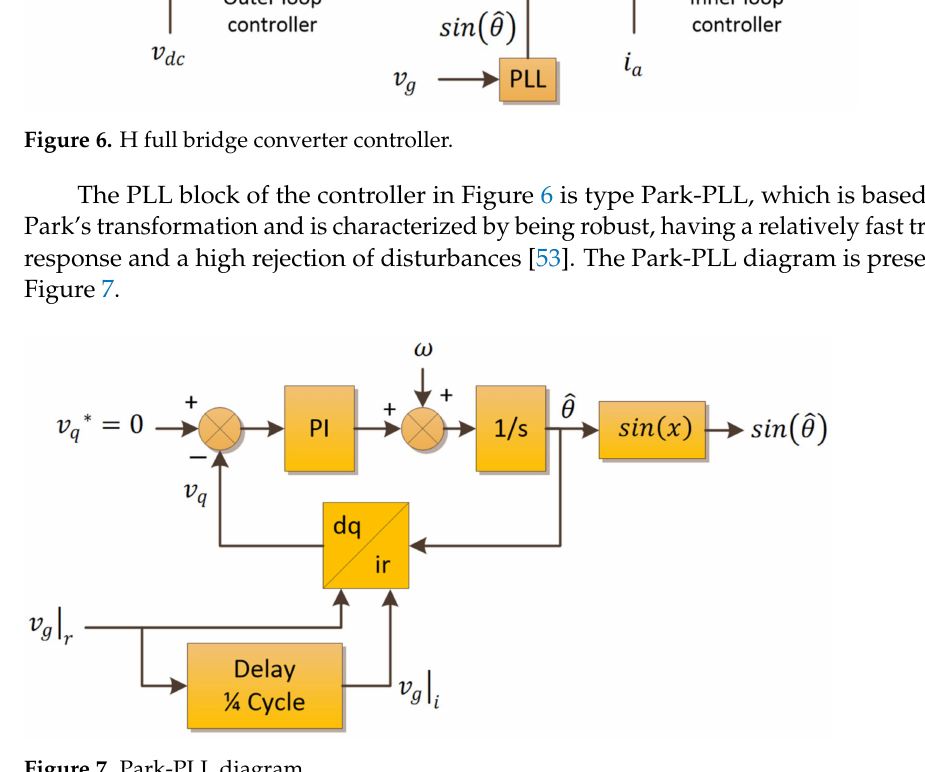
Figure 7. Park-PLL